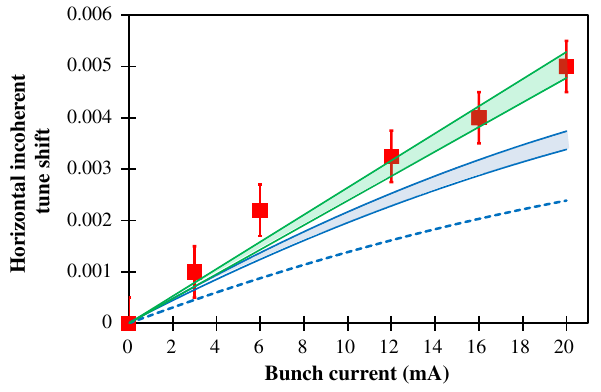
FIG. 8. Measured (red square) horizontal incoherent tune shift as a function of bunch current. Values expected from theory: without NEG coating and with bunch lengthening (blue dashed line); with NEG coating (0.5 and 1 . 0 μ m thickness) and with bunch lengthening (blue area); with NEG coating (0.5 and 1 . 0 μ m thickness) and without bunch lengthening (green